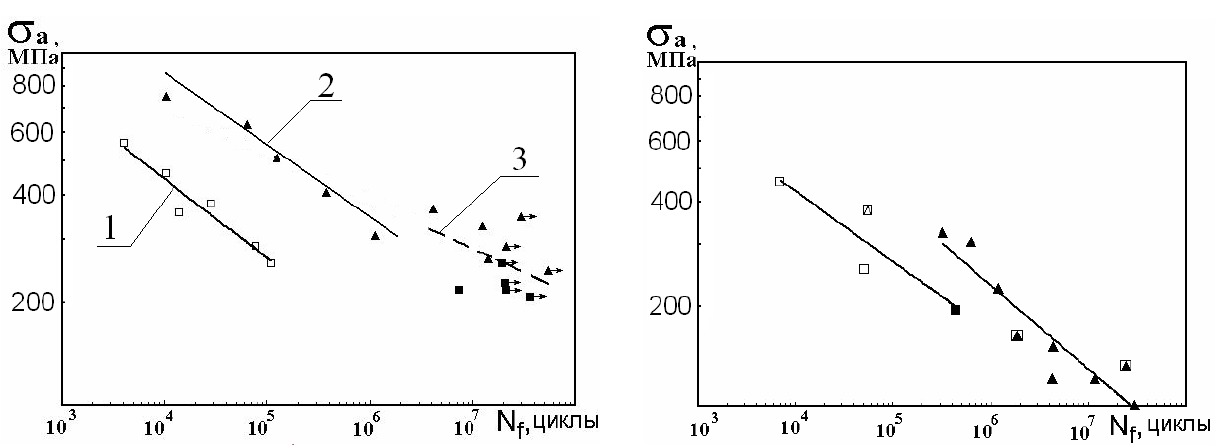
Figure 7. S-N curves: ( а ) for notched specimens subjected to stress ratio R=-1.0; (b) for smooth specimens at R=0.1. ▲ – TSP; □ – Т ; ■ – specimens failed under tension.